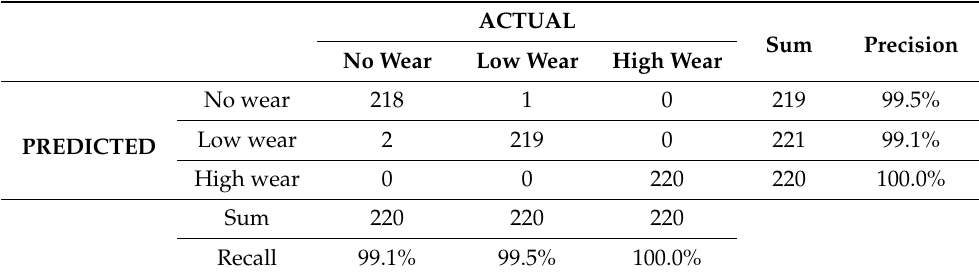
Table 10. Confusion matrix for the classification of the tool wear for three wear categories.